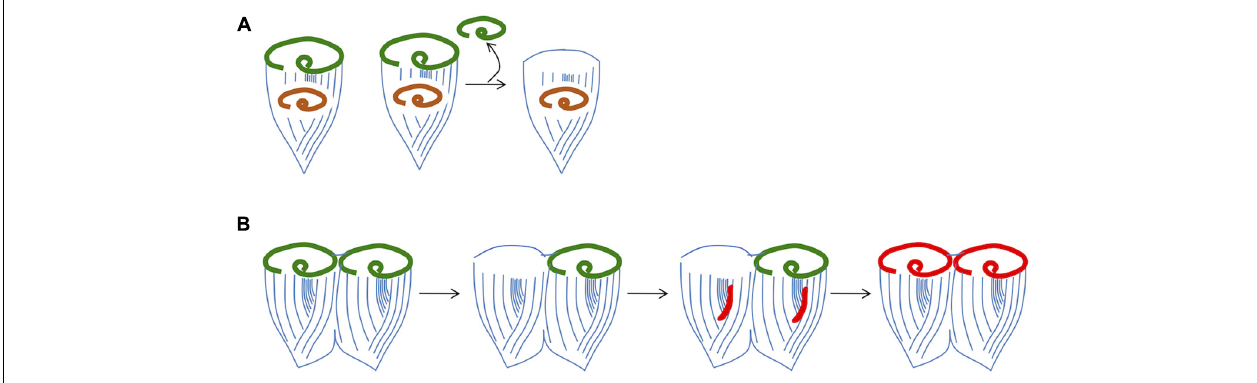
FIGURE 4 | Evidence that regeneration is inhibited by a signal from the existing oral apparatus. (A) Implantation of OA material into a cell prevents regeneration. The implanted OA is denoted by orange color. (B) Removal of one OA from a grafted doublet cell is able to trigger parallel regeneration and